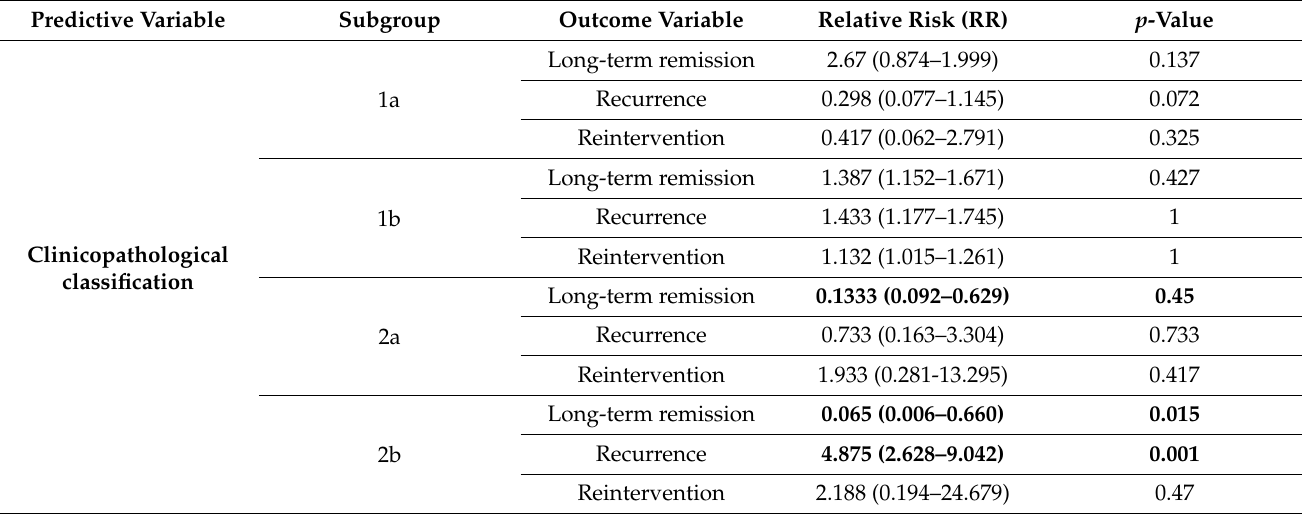
Table 2. Univariate analysis is presented. Each subgroup of the predictive variable clinicopathological classification is presented according to its statistically significant relation to the outcome variables (remission, recurrence, and reintervention) through Relative Risk and p -Value. Predictive